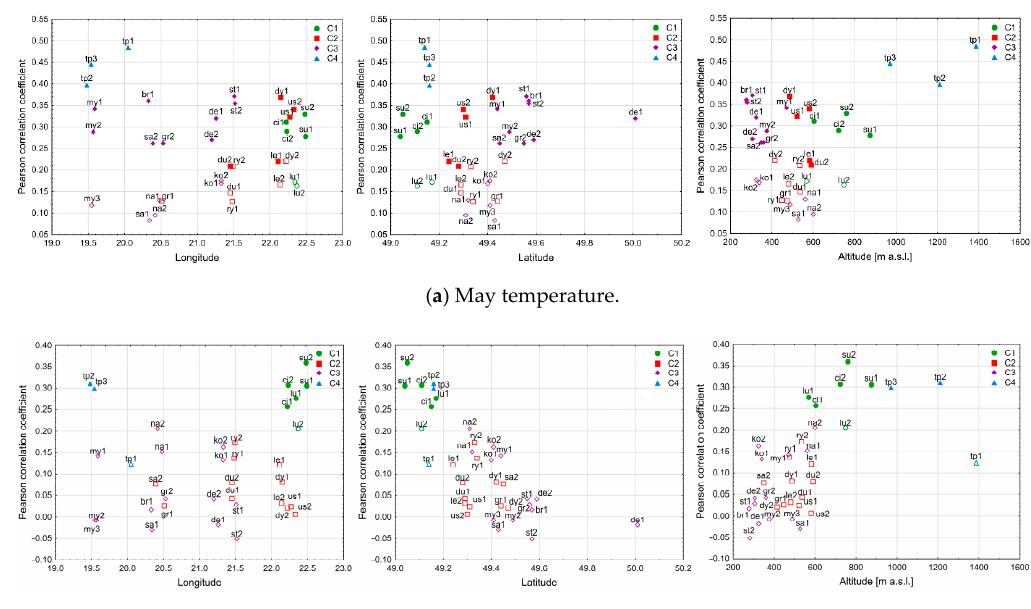
Figure 6. Results of climate–growth relationship analysis. Correlations were calculated from previous-year May (M-1) to current-year September (S). Mean values for particular clusters (as lines) were also presented (red line shows significant level). ( a ) Temperature; ( b ) precipitation.